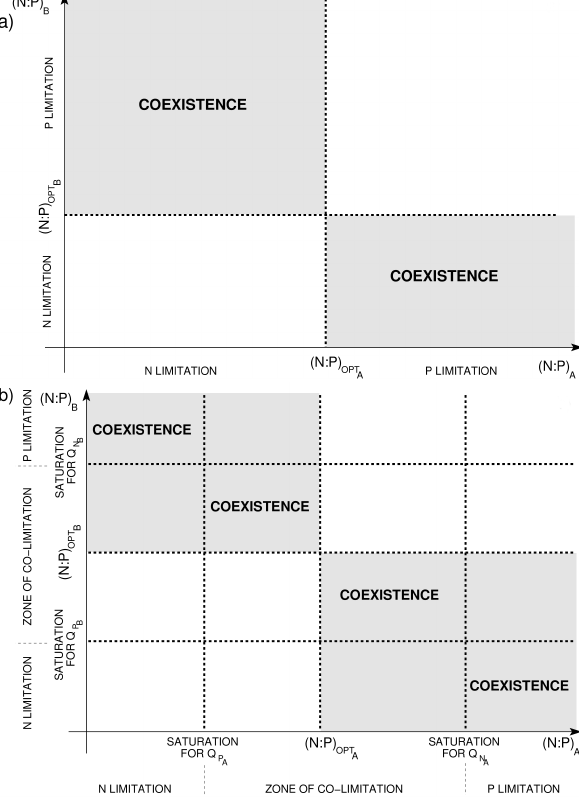
Fig. 8. Maximum uptake rate V max and per-cell uptake rate V=B for nitrogen (a) and phosphorus (b) as a function of the external nutrient concentration in the zone of co-limitation. V max decreases with increasing nutrient availability due to the down-regulation of the uptake proteins in the population. V max and V=B converge for large nutrient concentrations (dashed lines, see text).